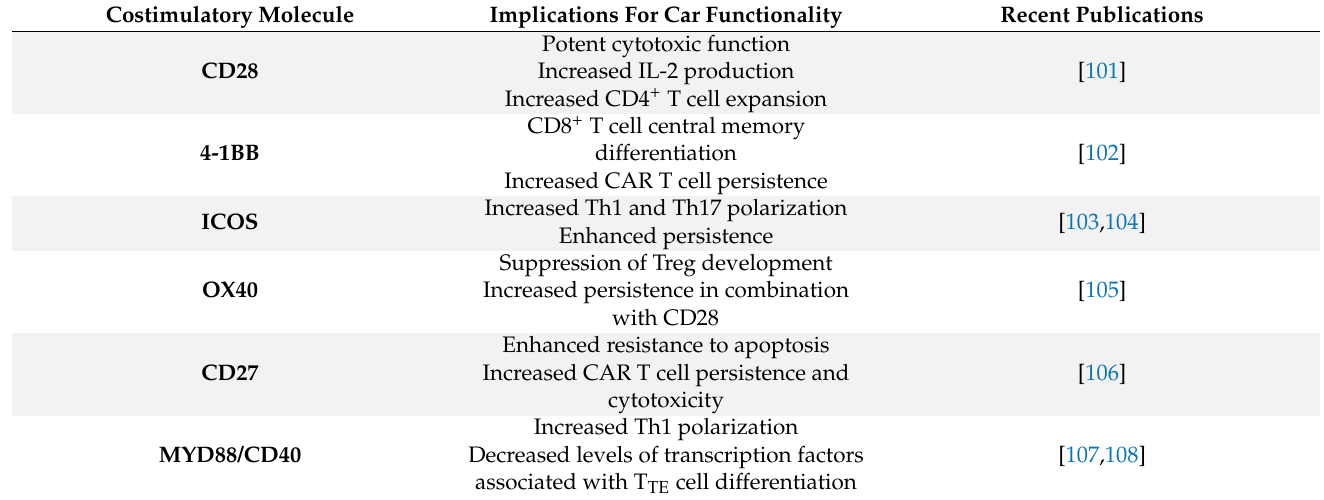
Table 2. Costimulatory signaling molecules used in CAR T cell design. Table adapted from Weinkove et al. [100]. Costimulatory